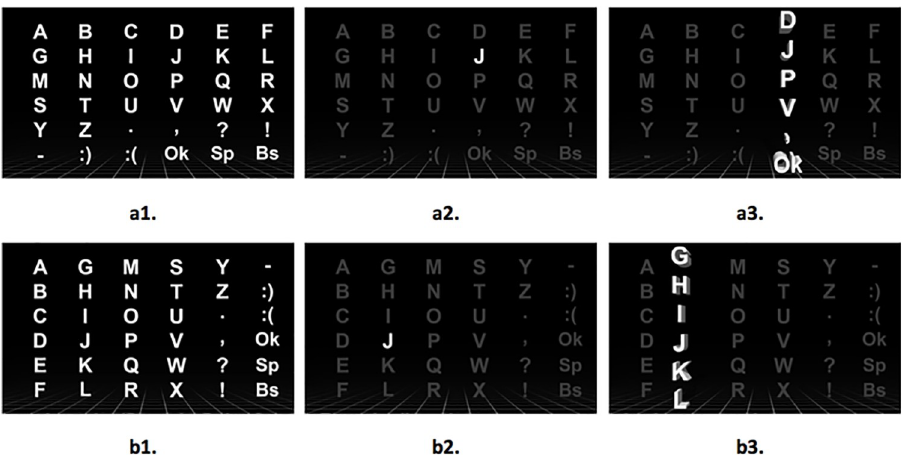
Fig 5. Three-dimensional column-based experimental